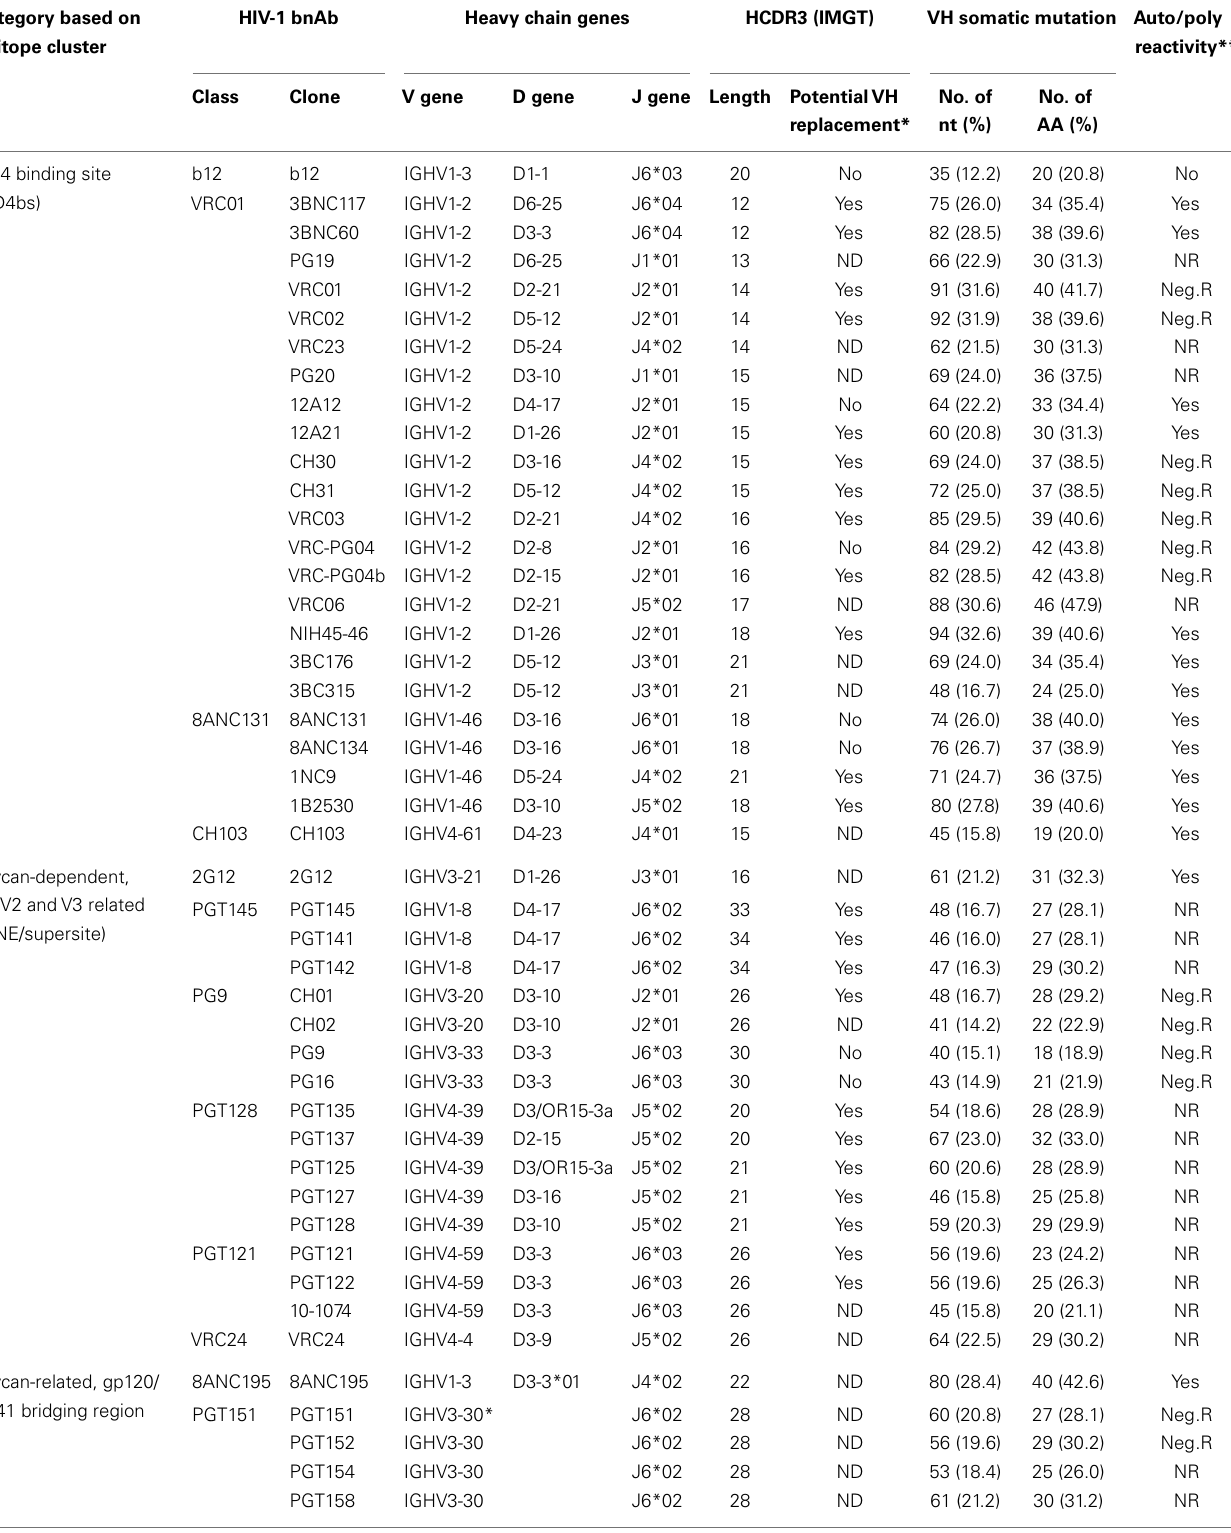
Table 1 | Characteristics of the heavy chainV-gene of HIV-1 broadly neutralizing antibody . Category based